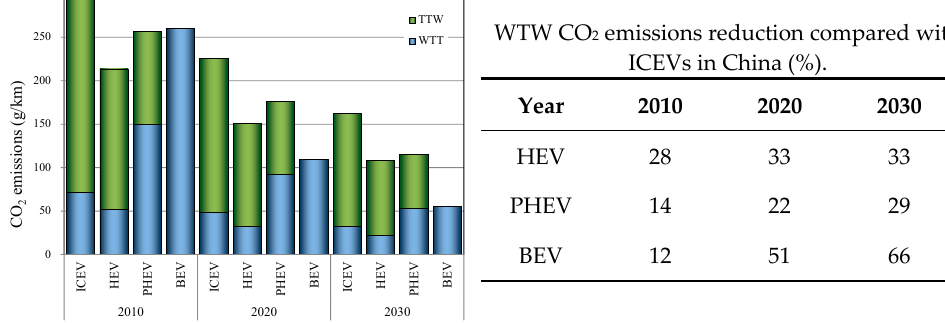
WTW CO 2 emissions reduction compared with ICEVs in Inner Mongolia (%).